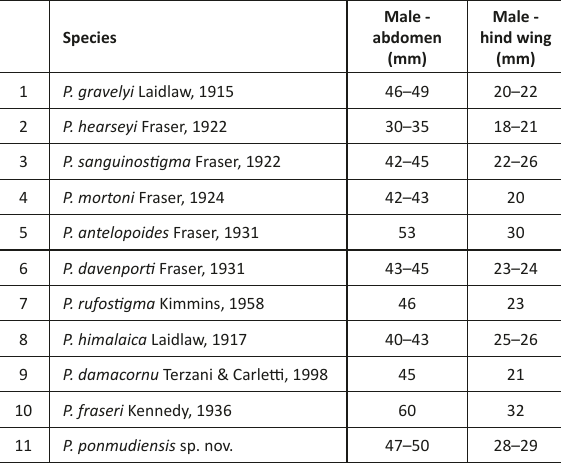
Table3. Morphometric measurements of males of Indian Protosticta Selys, 1885, based on Fraser (1933), Kimmins (1958), Terzani & Carletti (1998), Kiran & Raju